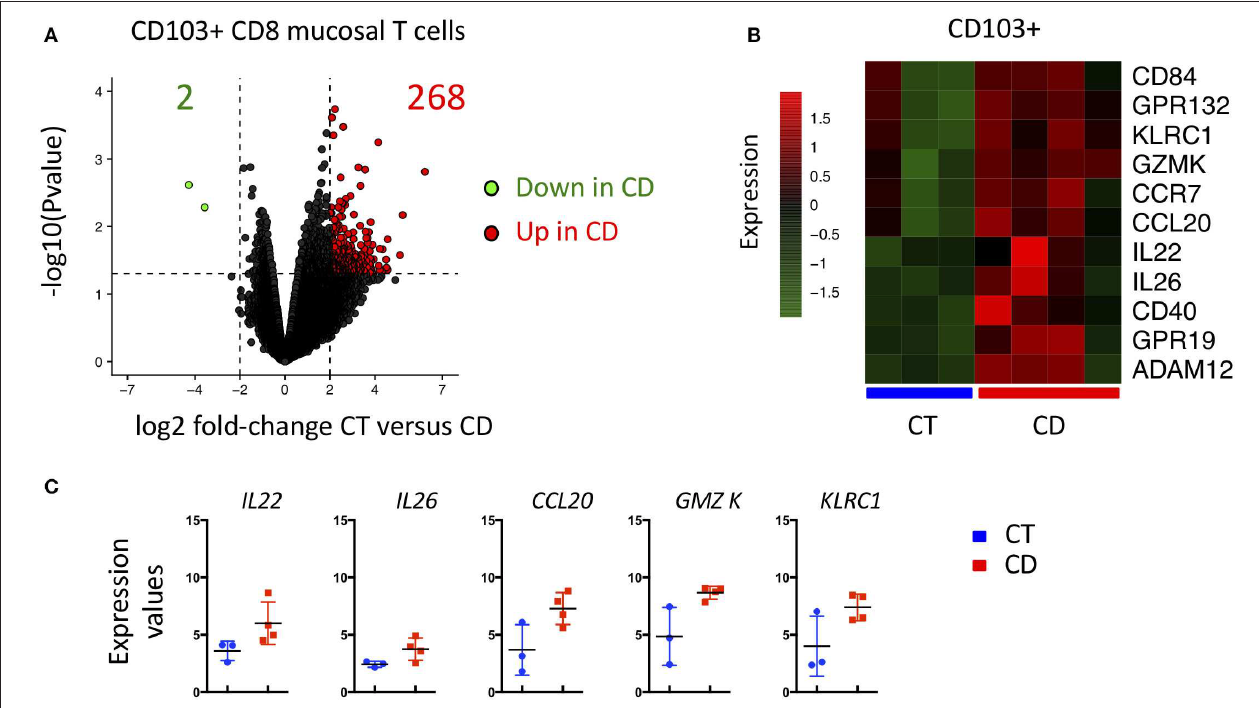
FIGURE 8 | CD103 + CD8 Trm cells from CD patient display major transcriptional change compared to CD103 + from CT. (A) Volcanoplot showing differential expression (fold change > 2 and P < 0.05) in CD103 + between control (CT; n = 3) and CD patients (CD; n = 4). (B) Heatmap of genes differentially expressed ( P < 0.05) between CD103 + mucosal T cells from CT and CD patients. (C) Quantification and distribution of expression value of genes of interest (dots and bars represent 3 and 4 independent experiments with mean and